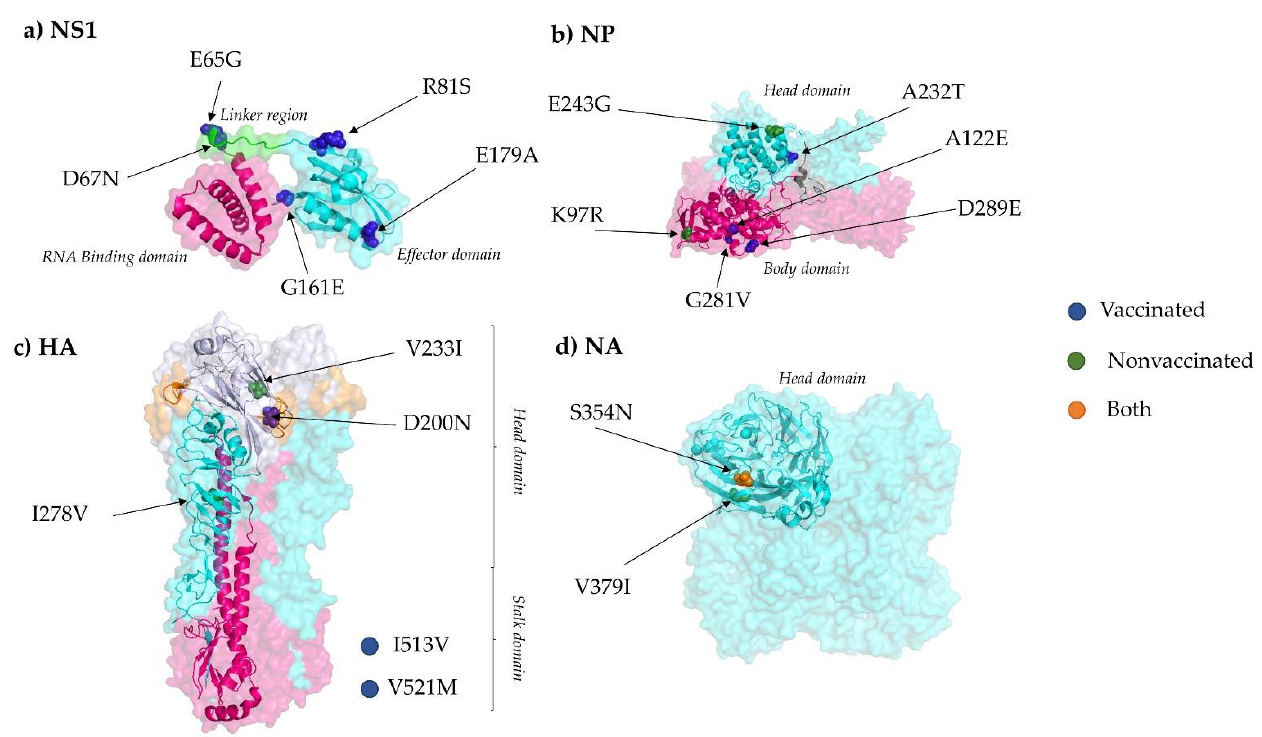
Figure 6. Location of all substitutions (allele frequency > 5%) described in this study in NS1, NP, HA, and NA proteins. ( a ) NS1 protein (PDB accession no. 4OPH) [61] RNA Binding (RBD), Linker region, and effector domain (ED) are highlighted in pink, green, and cyan, respectively. ( b ) NP trimer protein (PDB accession no. 2IQH) head domain is indicated in cyan, whereas body domain is highlighted in pink [64]. ( c ) HA trimer is also represented (PDB accession no. 3LZG); cyan, pink, and blue domains represent HA1, HA2, and Receptor binding domains, respectively. In orange, the CA antigenic site is highlighted [65]. I513V and V521M substitutions are not in the limit of the crystallographed structure. ( d ) NA tetramer (PDB accession no. 4B7Q) protein [66]. Finally, highlighted substitutions in blue were found in vaccinated animals, those in green were found in nonvaccinated animals, and those in orange in both. The PyMOL Molecular Graphics System, Version 4.3 was used to visualize the protein structures.